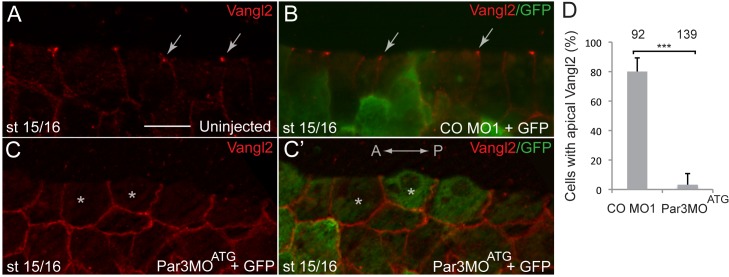
Par3MOATG inhibits apical accumulation of Vangl2 at the neural plate midline.Sagittal sections of stage 15/16 embryos were immunostained with anti-Vangl2 and anti-GFP antibody. The anteroposterior (AP) axis is indicated. Apical surface is at the top. (A, B) Vangl2 is enriched at the apical corners of cells at the neural midline in uninjected and CO MO1-injected embryos (arrows). (C, C’) Basolateral localization of Vangl2 at the cell junctions of Par3MOATG-injected embryos (asterisks). (D) Quantification of apical Vangl2 staining in CO MO1 and Par3MOATG-injected tissue. Number of counted cells is shown above the bars. Error bars represent standard deviation. Significance was determined by the two-tailed Student’s t-test, p<0.001 (asterisks). Scale bar, 20 mm.